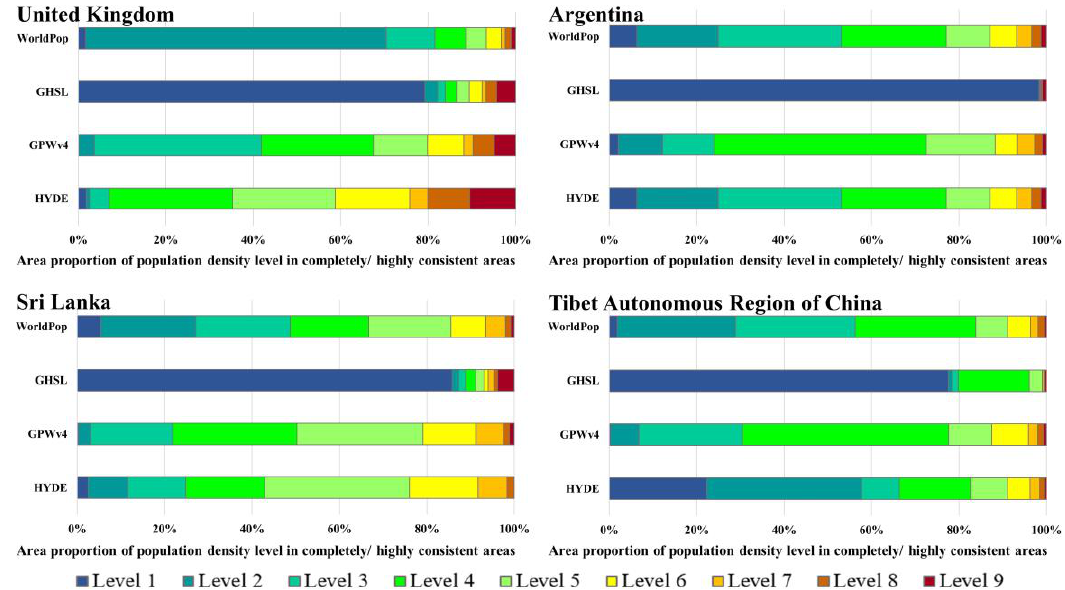
Figure 4. Area proportion of population density level in lowly consistent / completely inconsistent areas. Table 7. Area proportion of lowly consistent/completely inconsistent areas in medium population density areas.